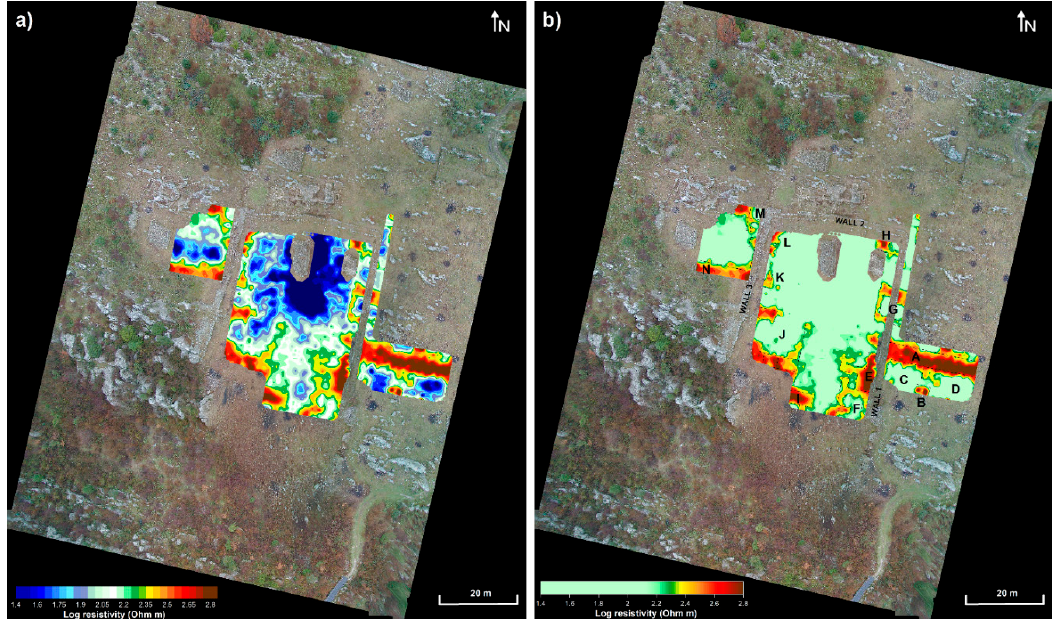
Figure 18. Sva č : representations of the electrical resistivity map relative to 1 m in depth using two different colour scales without ( a ) and with the indication of the main anomalies ( b ).